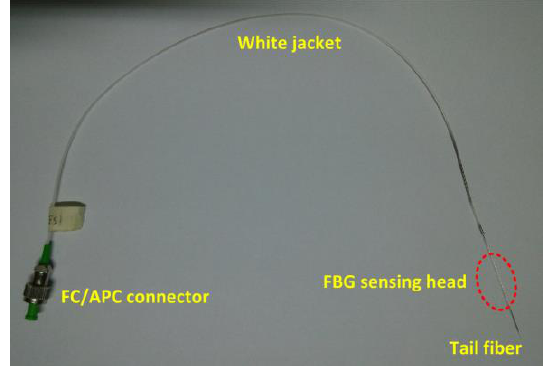
Figure 4. Physical view of D-FBG hydrogen sensor.